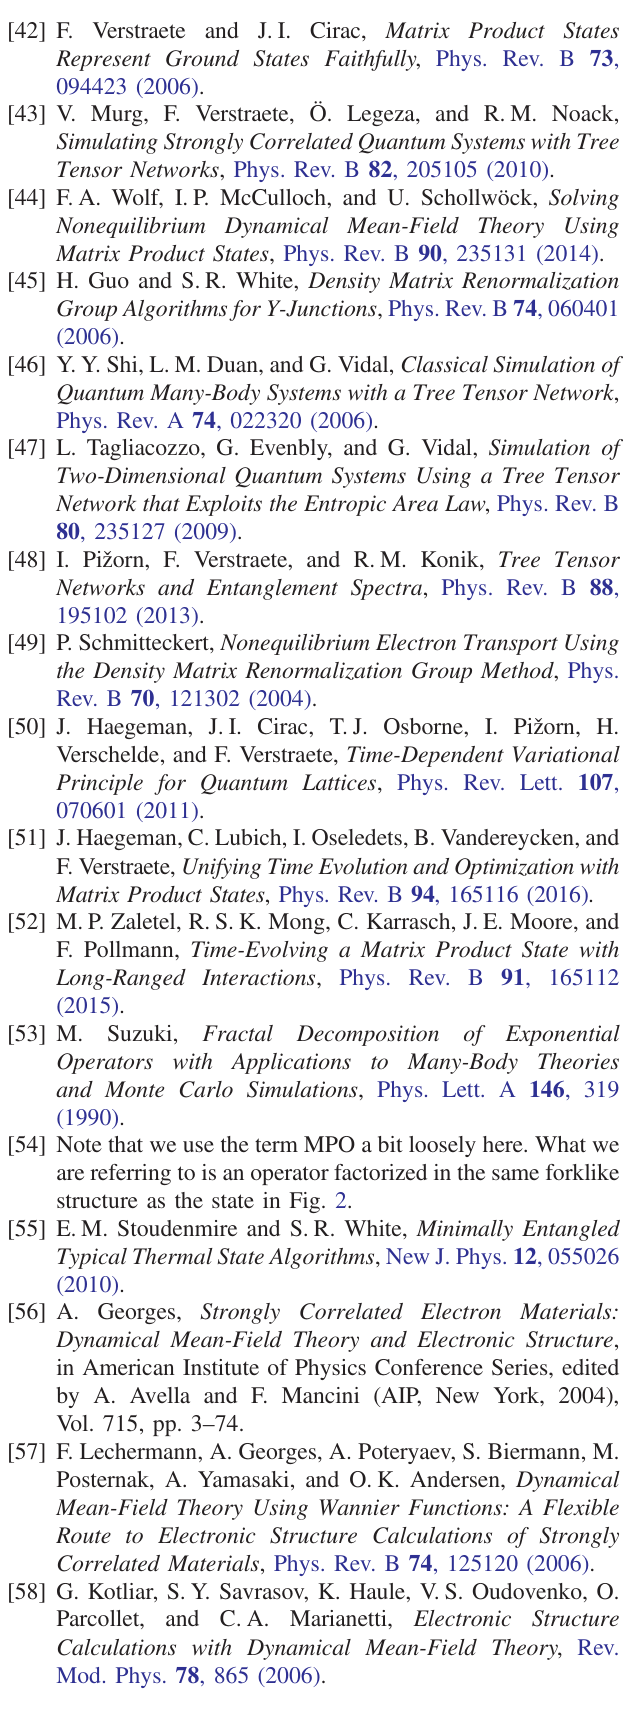
Diagrammatic Monte Carlo Method: General